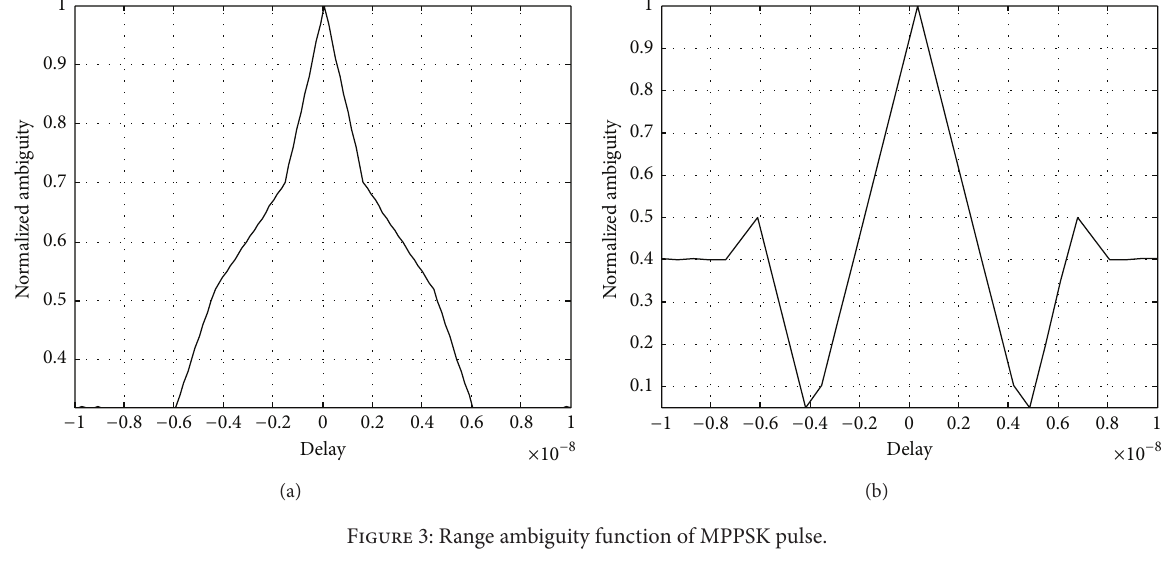
Figure 3: Range ambiguity function of MPPSK pulse.